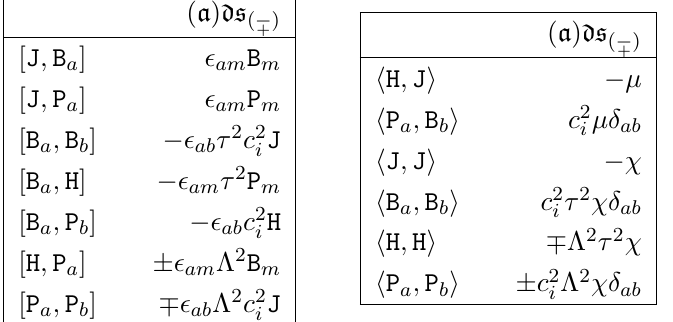
Table 1 . The (anti-)de Sitter spacetimes (left) and their most general invariant metric (right). The upper signs correspond to ads and the lower to ds . The invariant metric remains nondegenerate when c i ( (cid:22) 2 (cid:7) (cid:3) 2 (cid:28) 2 (cid:31) 2 ) 6 =